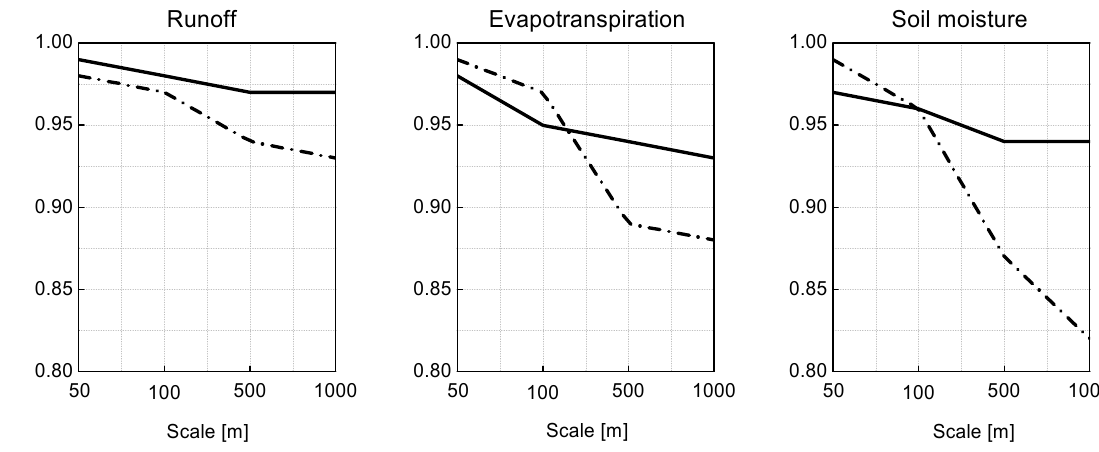
Figure 6. Model performances with and without subgrid parameterization. The solid line represents the NSC from the Grid-Xinanjiang model with uniform grid, and the dash-dot line represents the NSC after incorporating the subgrid